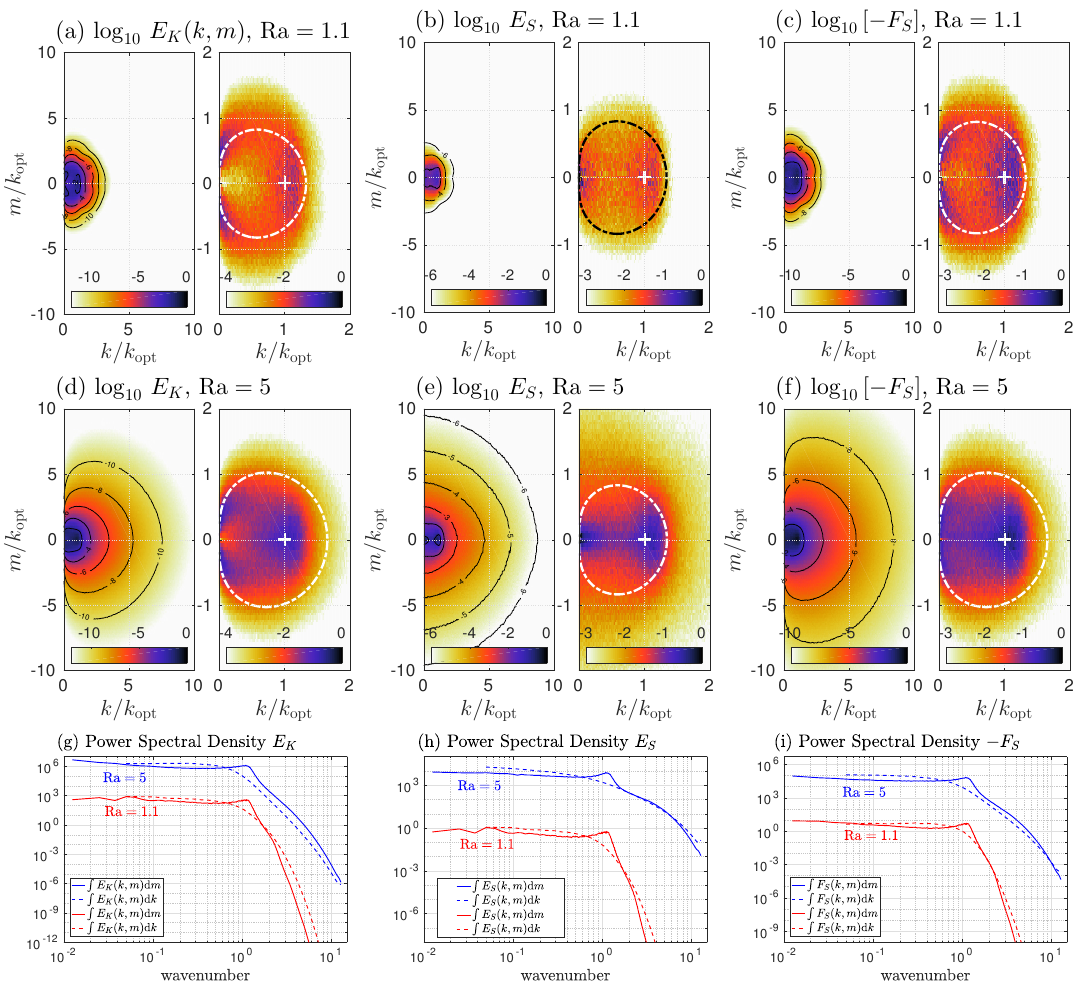
Figure 6. From left column to right column: Spectral density of kinetic energy ( a , d , g ), salinity potential energy ( b , e , h ) and salinity flux ( c , f , i ). The top row and middle row correspond to Ra = 1.1 and Ra = 5, respectively, and are organized as follows: each subfigure consists of two panels, the left of which contains a bidimensional spectrum of one of the aforementioned three quantities, while the right panel contains a close-up of the left panel. In the close-up panels, the thick dashed lines correspond to the marginal stability boundary, and the cross indicates the most unstable mode. Bottom row: corresponding integrated spectra along the vertical (plain lines) and horizontal (dashed lines) directions, plotted as a function of the horizontal and vertical wavenumber, respectively, for Ra = 1.1 (red lines) and Ra = 5 (blue